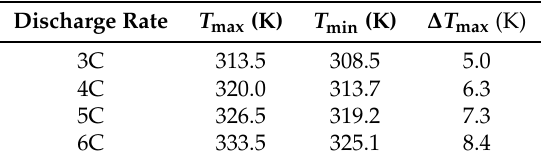
Table 4. Numerical results for various discharge rates of the battery pack.